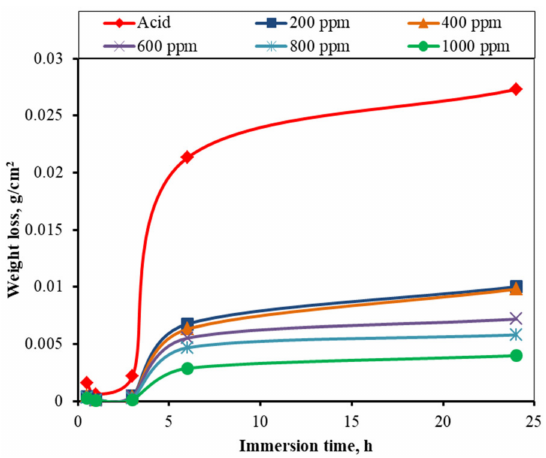
Figure 4. Variation of weight-loss with immersion time for the corrosion of mild steel in a solution of 1 M H 2 SO 4 and in solutions of different inhibitor concentrations at room